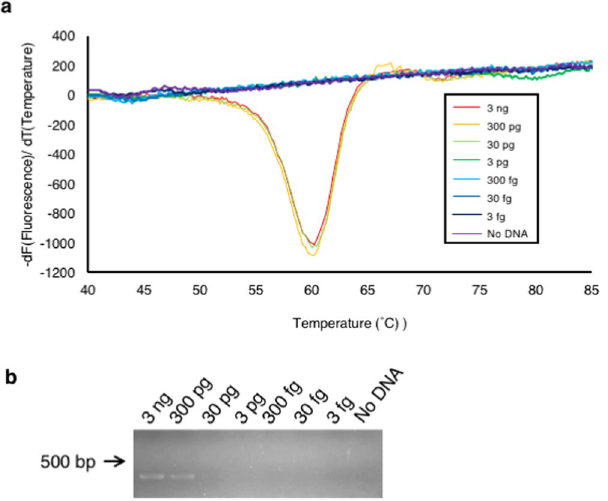
Figure 4. Comparison of relative sensitivity of LAMP with the universal QProbe and conventional PCR ( a ) Melting curve analysis following LAMP reaction with serial tenfold dilutions of genomic DNA of Fol race 1